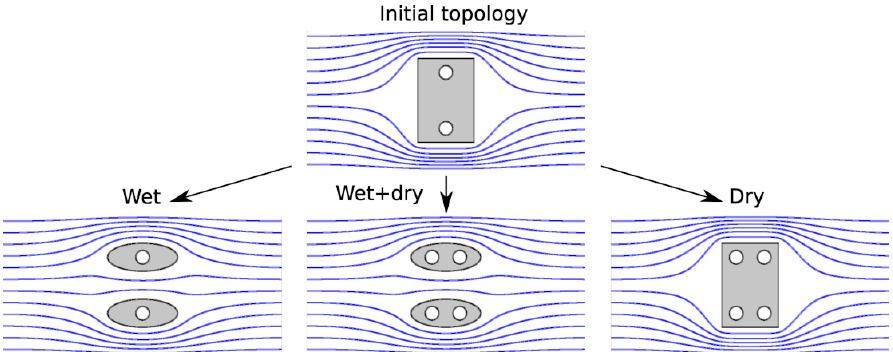
Figure 3. Description of different degrees of design modification for fluid–structure interaction (FSI)